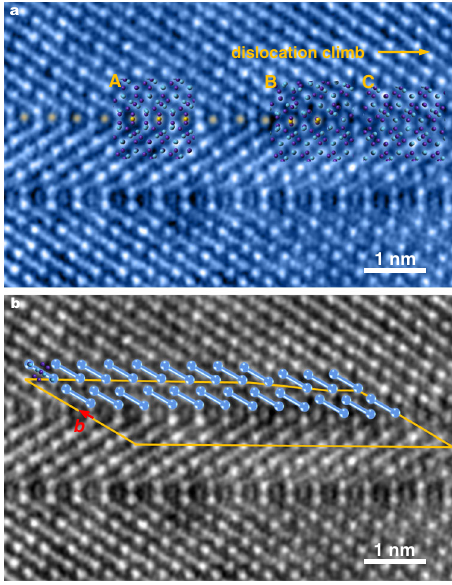
Fig. 3 The HAADF image projection along [1-11] μ showing the transformation from (110) FTB of μ phase to P (or σ ) phase in progress. a is lightly colored to enhance brightness and contrast. The positions of the diffusing-in atoms during phase transformation are colored orange. Boxes A – C in ( a ) correspond to the three sequential stages that catch the phase transformation in progress; At location A, the transformation to the partial structure of P (or σ ) phase is completed. Location B captures a snapshot of the core of the climbing dislocation, i.e., the boundary zone between A and C (the original (110) FTB of the μ phase). The orange arrow marks the direction of both the dislocation climb and the progressive phase transformation. The purple and blue atoms represent (Co, Cr, Ni) and (W, Mo, Re), respectively. b illustrates the Burgers vector circuit of the climbing dislocation. The dumb-bell symbol represents a structure unit containing the atoms in seven nonequivalent (110) layers of the μ phase. The orange Burgers circuit fails to close (compare with the closed Burgers circuit of FTB in Supplementary Fig. 9a), and the red arrow shows the Burgers vector that can be decomposed into a horizontal and vertical component, and they are consistent with b ∥ and b ⊥ in Fig. representing different stages of transformation (propagating to the upper right along the orange arrow). The arrangement of atoms in region A (containing thicker and more P phases) is shown in Fig. 5b, where the conversion is over and all distortions have relaxed. The tip of the transformation zone is now reaching region B (transition zone), in which the lattice distortion strain is still discernible. At the upper right, the atoms in region C (containing thinner and fewer P Phases) are arranged as shown in Fig. 5c, and its transformation to region A, has not yet begun. Comparing the atomic arrangement of region A and region C, it can be found that, except for some atoms in the blue block layer (thickness of 4D) of region A, the arrangements of the atoms on both sides above and below are exactly the same as region C. Also, in terms of the atom numbers and the relative positions between atoms, the blue block layer is consistent with the same block layer of region C. We can deduce from this sequence of events that the transformation from region C to region A, i.e., the thickening process of intergrowth P phase can be accomplished by the short-range diffusion (shuf fl e) of local atoms, and it is similar to a horizontal fl ip from the planar view. This transformation changed the distribution and spacing among FTBs (shown by black dotted line in Fig. 5b, c), and the number of FTBs with a spacing of 2D increased signi fi cantly after the transformation. Figure 4 shows that the regular P phase requires a spacing of 2D between FTBs, so the transformation from